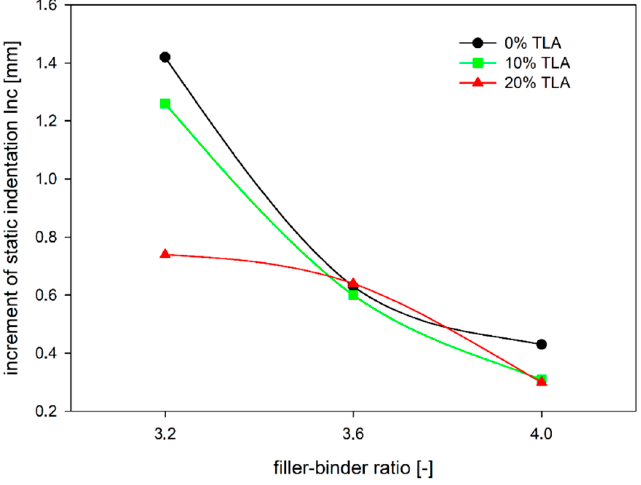
Figure 8. The dependence of increment of MA static indentation on the filler–binder ratio for different TLA contents.